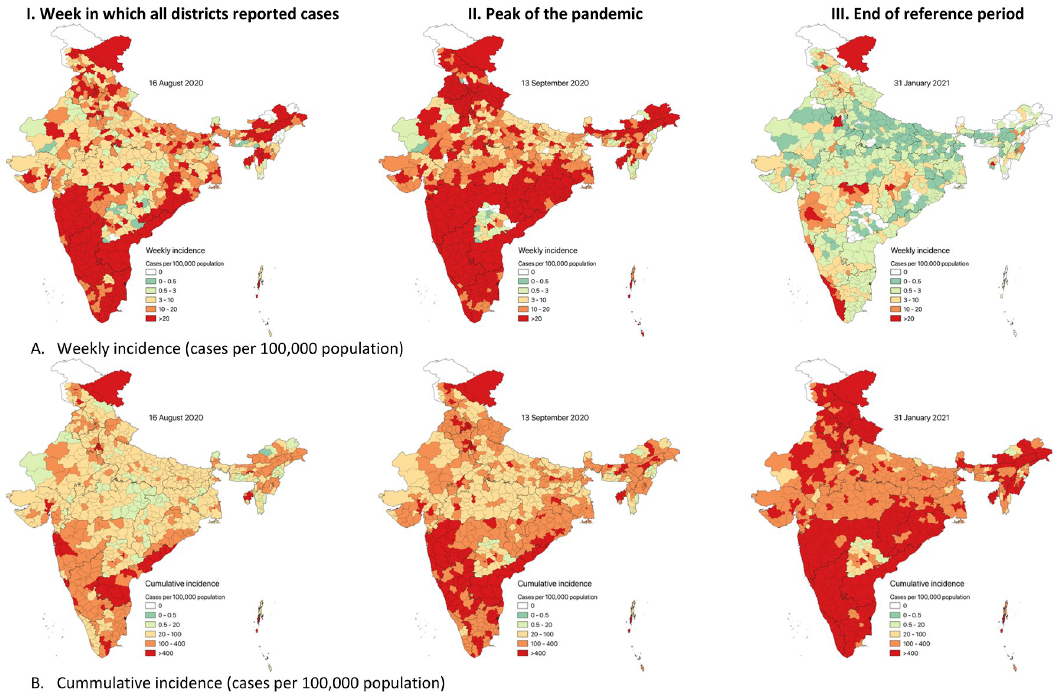
Fig 4. Weekly and cumulative incidence of laboratory-confirmed COVID-19 cases by the district of residence, India (March 2020 to January 2021).